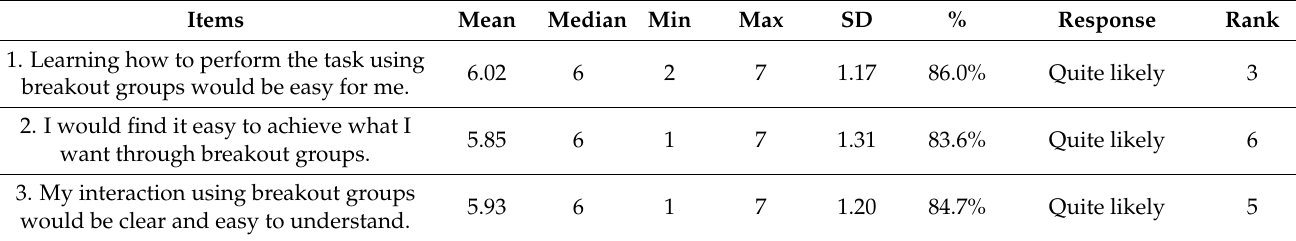
Table 11. Descriptive statistics for perceived ease of